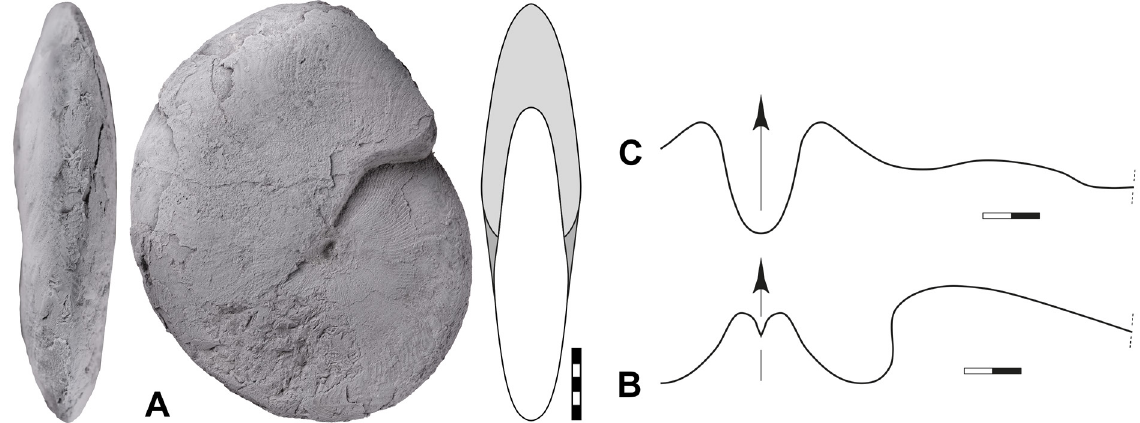
Scale bar units = 1